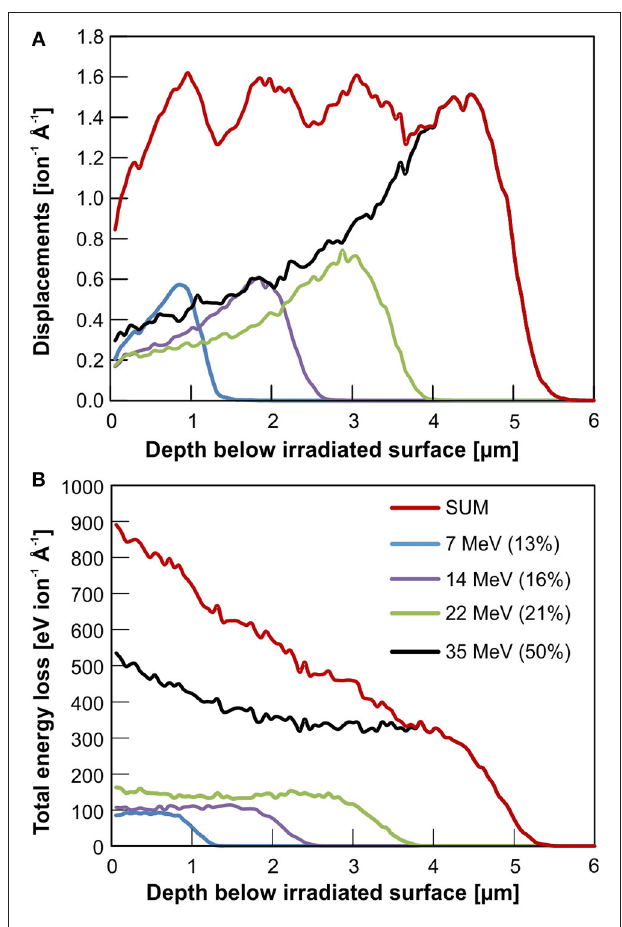
FIGURE 2 | Monte Carlo simulation (SRIM-2013 code; Ziegler et al., 2010) of quadruple Au-ion irradiations of xenotime-type YPO 4 using four different ion energies: 35, 22, 14, and 7 MeV. Relative fluences of 50, 21, 14, and 7% of the total fluence, have been chosen, respectively, to generate a homogeneous damage profile over a maximum irradiation depth of 5 µ m as expected from the cumulative displacements predicted by SRIM (A) . The total energy loss of an incoming Au ion over the irradiation depth is shown in (B) . The latter comprise energy loss by nuclear (knock on) as well as electronic interaction (deceleration by coulomb interaction) with the